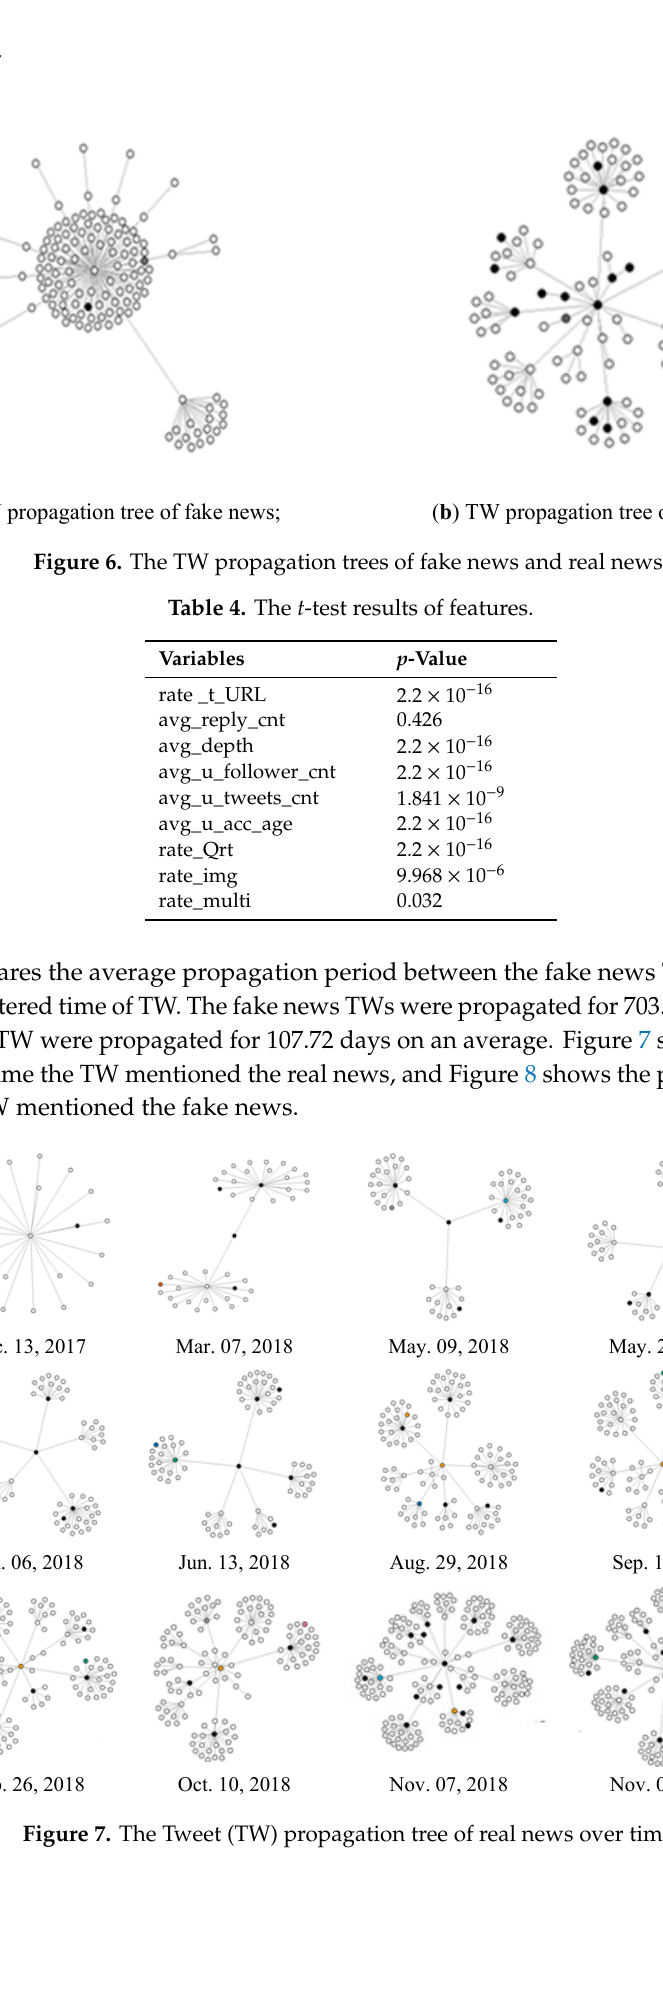
Table 4. The t -test results of features. Variables